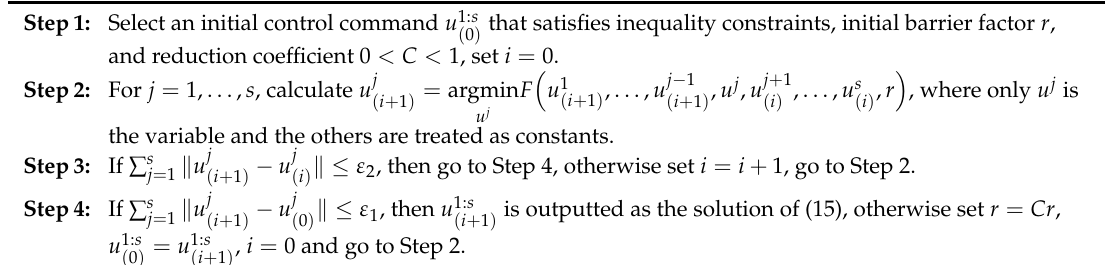
Table 2. Mixed penalty function (MPF) method for constrained multi-sensor